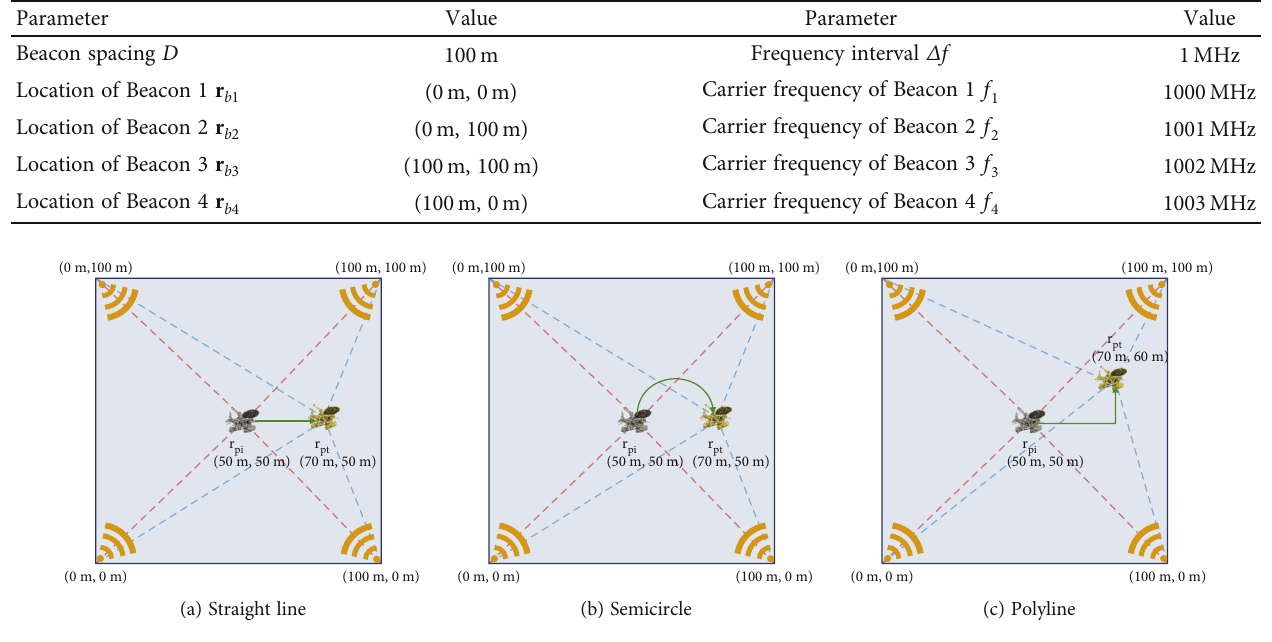
Figure 6: Three typical trajectories investigated in the simulation. Table 3: Detailed parameters of the three